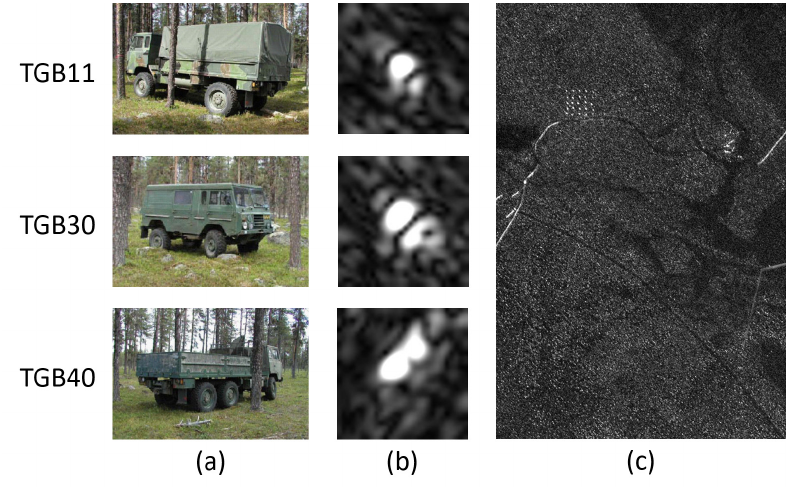
Figure 3. ( a ) Terrain vehicle targets [35] ( b ) Extracted Synthetic Aperture Radar (SAR) targets ( c ) Example image from the CARABAS-II VHF-Band SAR